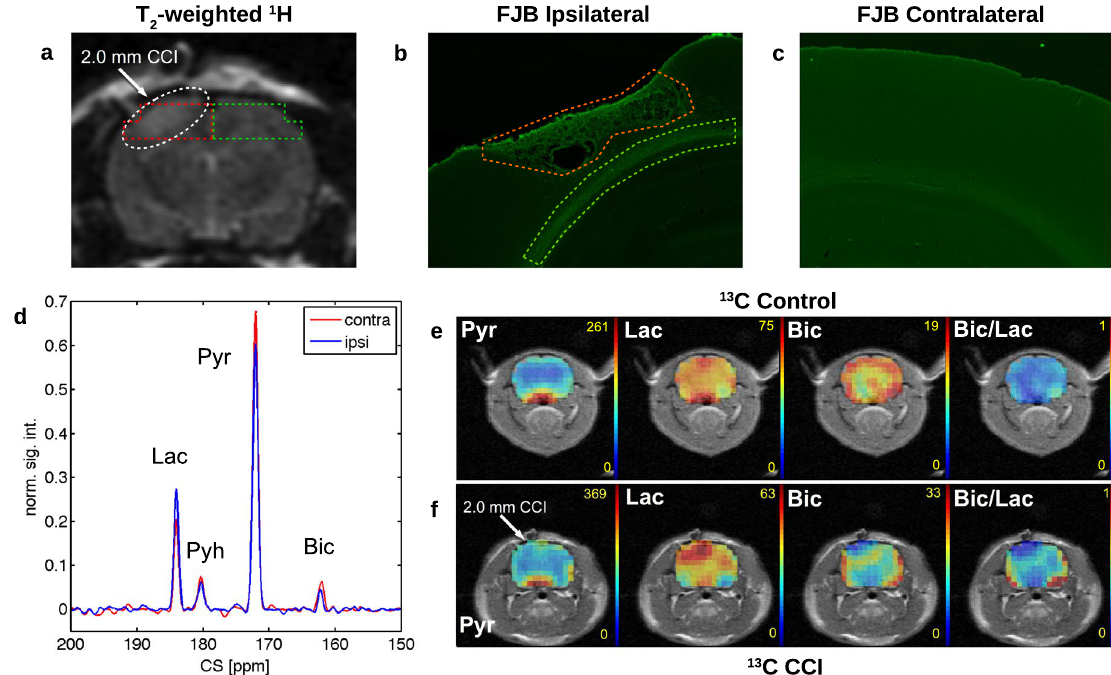
Figure 1. ( a ) T 2 -weighted proton image showing diffuse injury to the cerebral cortex following CCI injury. The ipsilateral and contralateral regions of interest (ROIs) are shown by red and green outlines, respectively. ( b ) and ( c ) Fluoro-Jade B staining of the ipsilateral and contralateral hemispheres, respectively, 30 days after CCI injury. Fenestrated, dead tissue is outlined in orange and dead or dying cells are outlined in green. ( d ) Two typical hyperpolarized 13 C MRSI spectra taken from ROIs on either side of the brain in an injured animal, showing an increase in lactate (lac) and decrease in bicarbonate (bic) intensity on the ipsilateral side. Pyruvate (pyr) and pyruvate hydrate (pyh) are also shown. ( e ) and ( f ) Maps of 13 C signal for pyruvate (pyr), lactate (lac), bicarbonate (bic), and the bicarbonate-to-lactate ratio (bic/lac) in the rat brain of a control animal and an animal injured with a 2.0 mm deep controlled cortical impact (CCI), respectively. Significant differences in lac, bic, and bic/lac are evident in the brain surrounding the site of injury versus the rest of the brain. The control animal shows a more symmetric signal